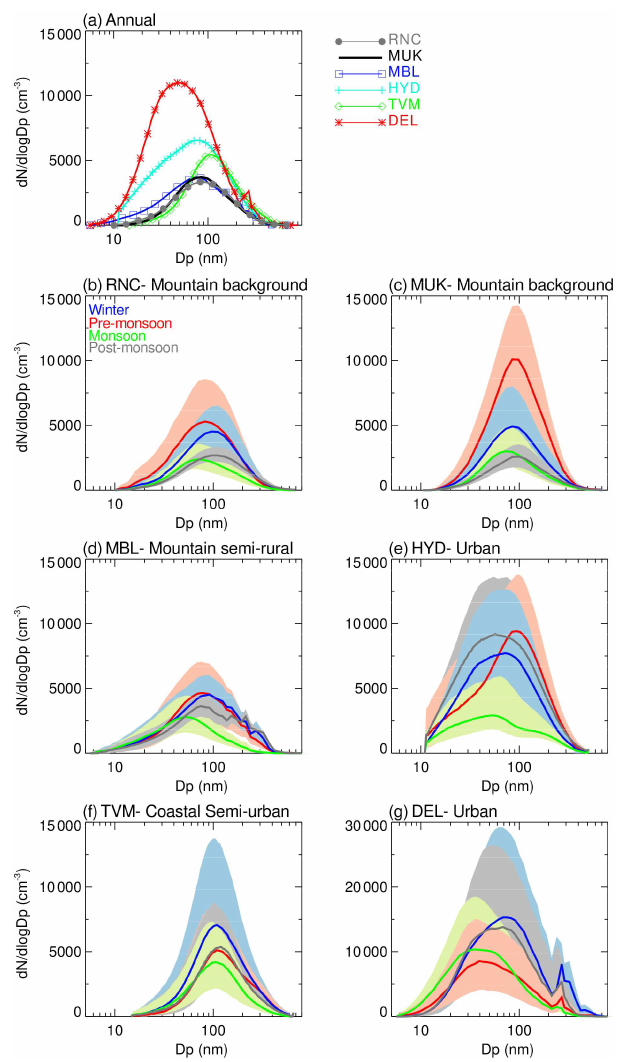
Figure 3. (a) Annual and (b–g) seasonal median particle number size distributions at all the sites. The solid line indicates the median, and the light-colored shading indicates 25th and 75th percentile dis- tributions. The blue line and shading indicate winter (DJF), red line and shading indicate pre-monsoon (MAM), green line and shading indicate monsoon (JJAS), and gray line and shading indicate post- monsoon season (ON). Note that the y axis scale is different for the DEL site. Note that measurements are from different time periods for each site (see Table